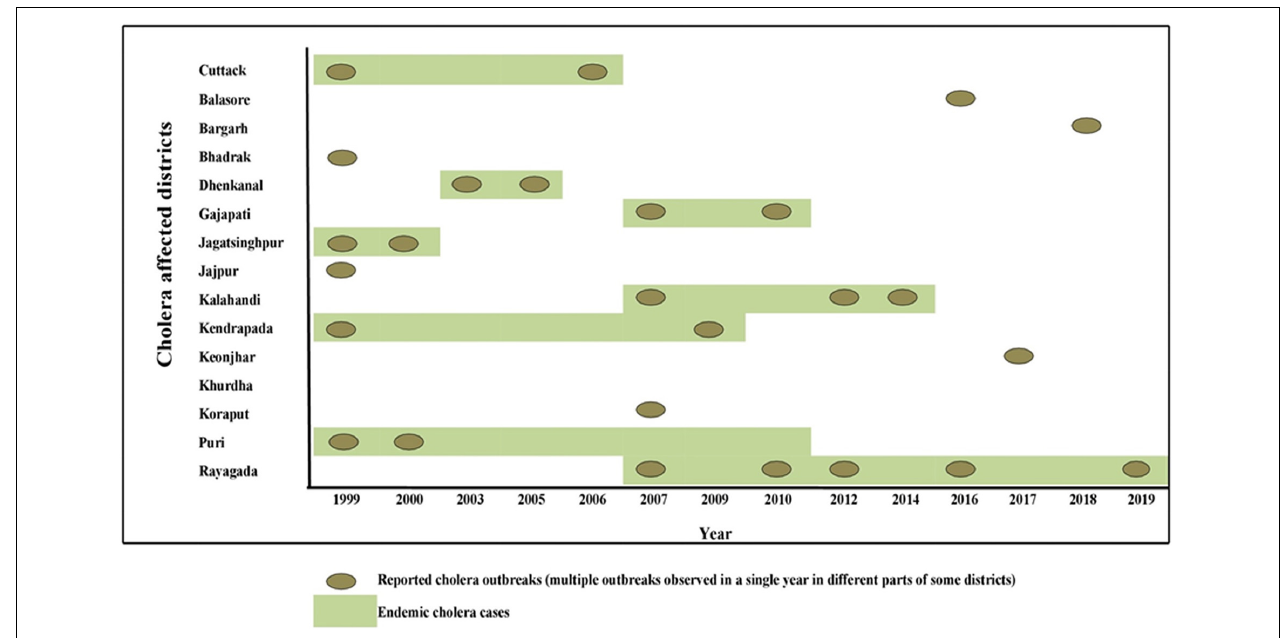
FIGURE 1 | Distribution of cholera cases and outbreaks in Odisha: